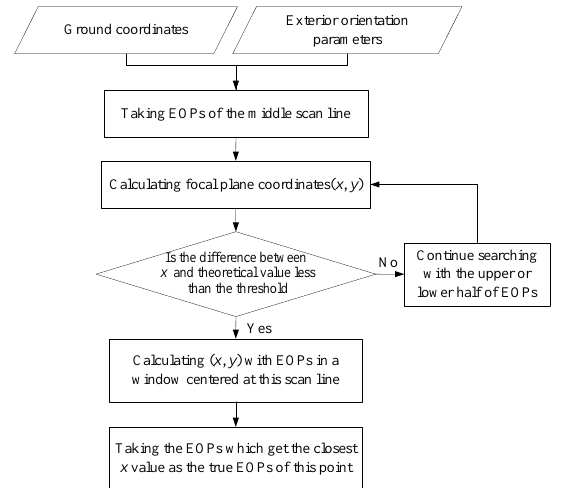
Figure 2. Back projection using binary